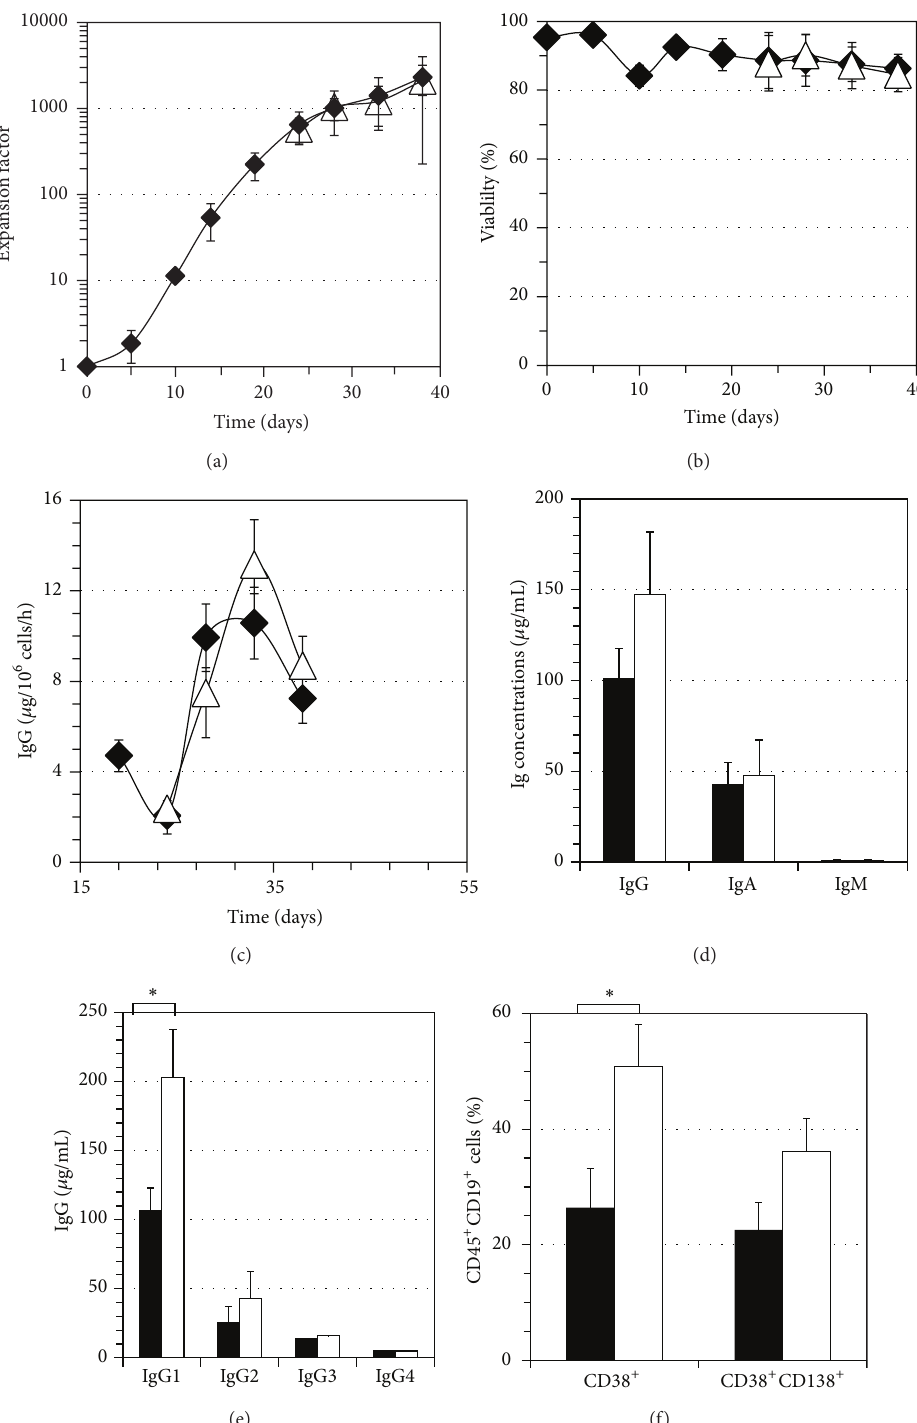
Figure 1: In vitro plasma cell generation and cytokine microenvironment. B lymphocytes were expanded for 19 days with IL-2, IL-4, and IL-10 at high interaction level with CD154. The same interleukin combination was used for the differentiation phase (filled symbols and bars) or the cells were cultured from day 19 with a combination of IL-6 and IL-10 (empty symbols and bars). The transition and differentiation phases lasted a total of 18 days with a low CD154 interaction. The results shown are the mean of 6 independent experiments. (a) Cell expansion, (b) cell viability, (c) IgG secretion rate in the differentiation environment, from D19 to D38, (d) IgG, A, and M secretion on day 33 supernatants, and (e) IgG subclasses secretion on day 33 supernatants. A significant difference was noticed in IgG1 secretion among the two interleukins combinations. Statistical analyses were done using the Bonferroni 𝑡 -test and the 𝑃 value was < 0.05 (f) CD38 and CD38 + CD138 + cells frequency. The IL-6-10 combination generated a larger CD38 + cell population on day 33, confirmed by a paired 𝑡 -test, 𝑃 value = 0.0188. All errors bars stand for SD and can be smaller than